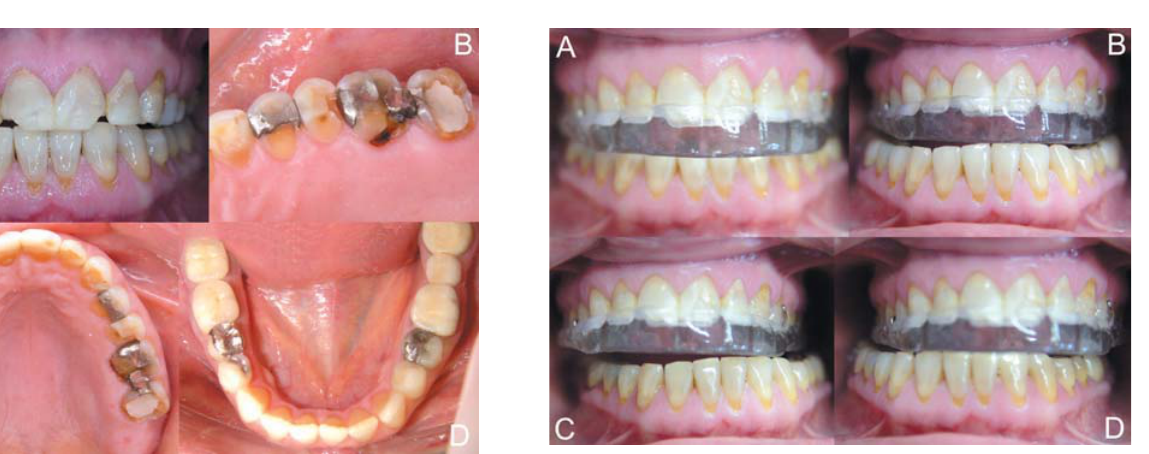
FIGURE 1- Initial aspect of the patient. A: extensive restorations on maxillary anterior teeth and worn incisal edges; B: corrosion of occlusal surfaces of maxillary posterior teeth; C: salient and fractured amalgam restorations; D: mandibular teeth with normal appearance